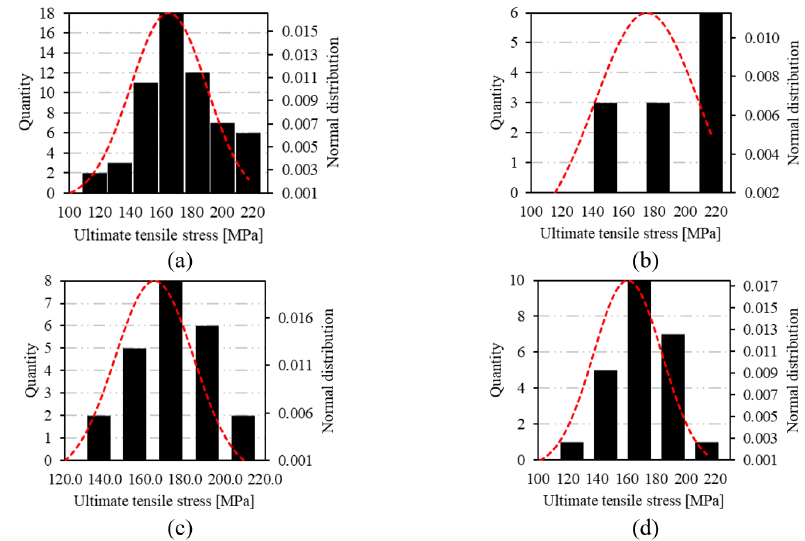
Figure 12. Histograms and normal distribution curves of ultimate tensile stress test results for: (a) all specimens; (b) group A; (c) group B; (d) group